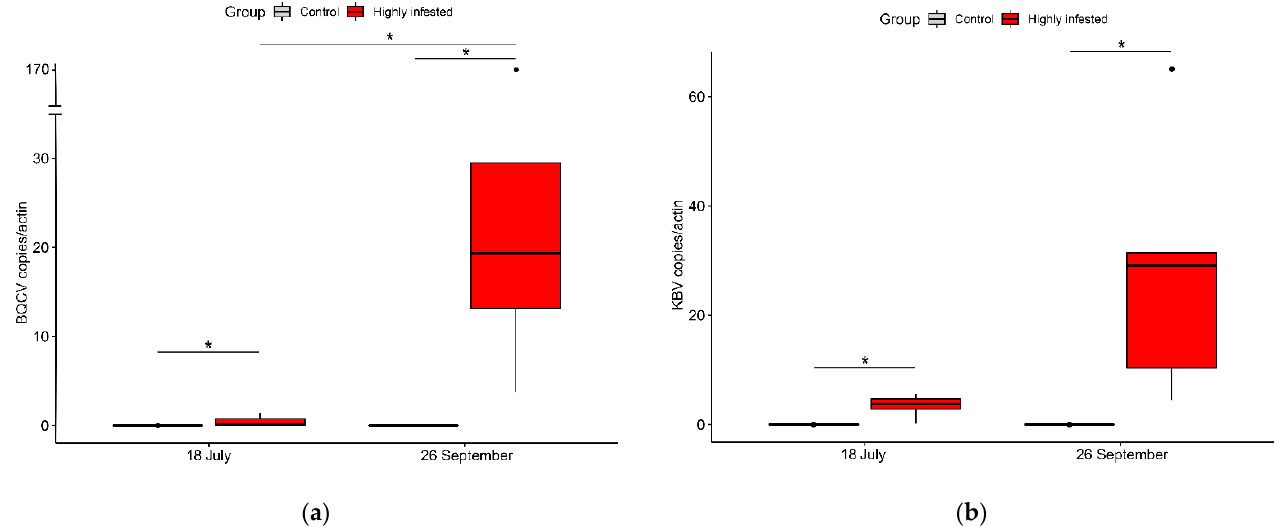
Figure 4. Viral loads in in honeybees of highly infested and control hives over time: ( a ) BQCV loads (copies/actin); ( b ) KBV loads (copies/actin). Viral copies/actin for BQCV and KBV were significantly different between the two studied groups (*, p < 0.001, linear model and Mann – Whitney test) at each period of the cohort study. There was a great increase of BQCV copies/actin in highly infested hives over time (*, p < 0.001, linear model).